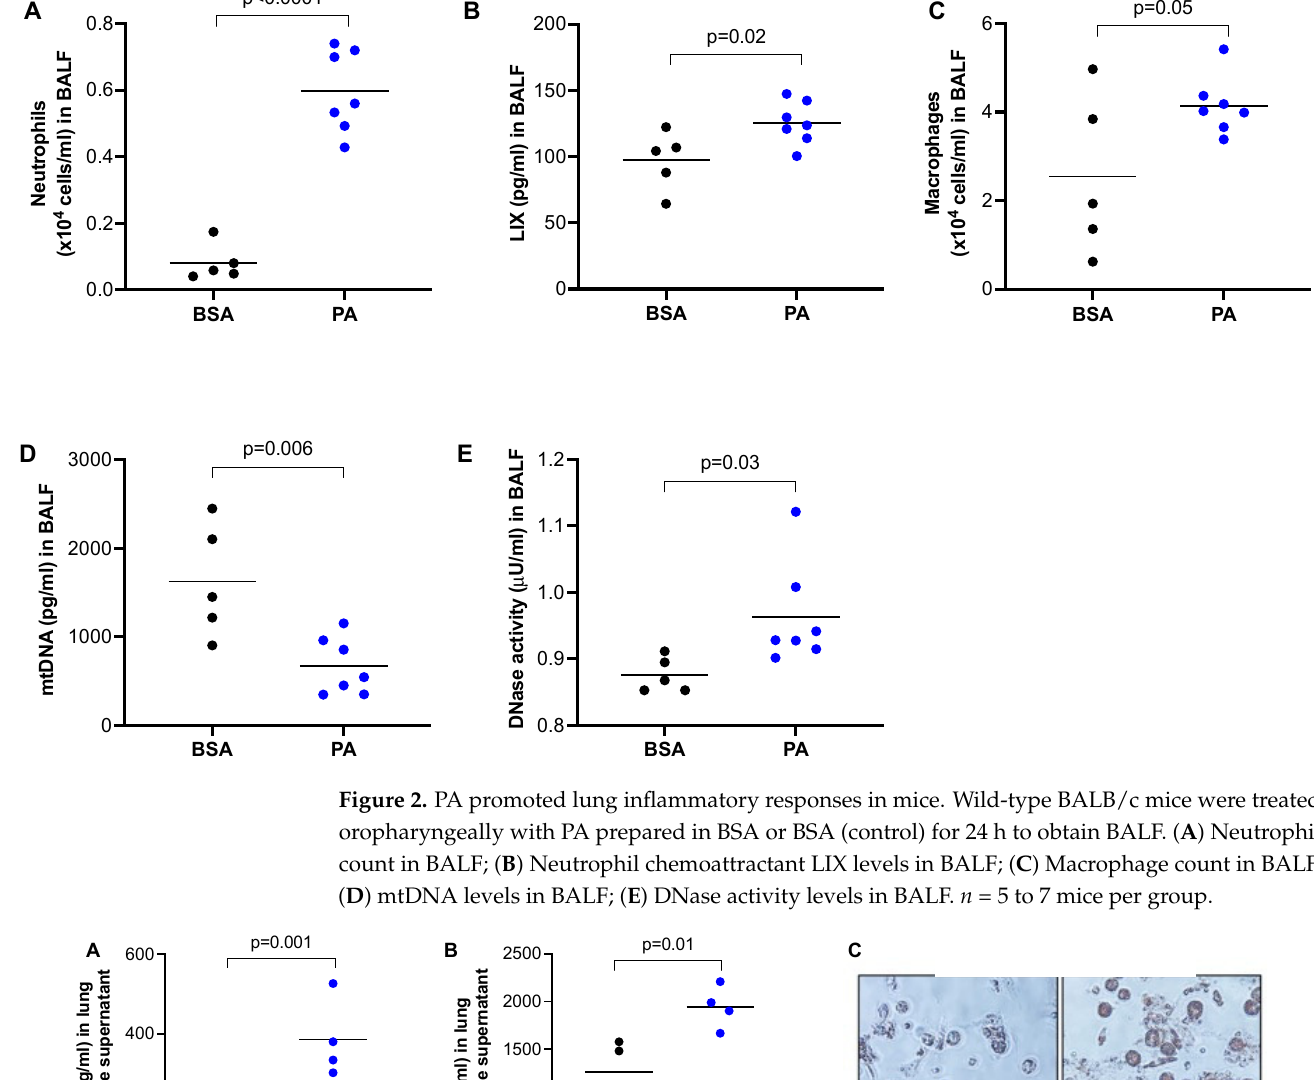
Figure 3. PA enhanced mtDNA and pro-inflammatory cytokine release from lung macrophages. Lung macrophages isolated from wild-type C57/BL6 mice were cultured and treated with PA (1 mM) and prepared in 0.1% BSA or 0.1% BSA (control) for 24 h to obtain the supernatants for measuring p=0.01 mtDNA ( A ) and neutrophil chemoattractant KC ( B ). ( C ) Oil red O staining in macrophages plated